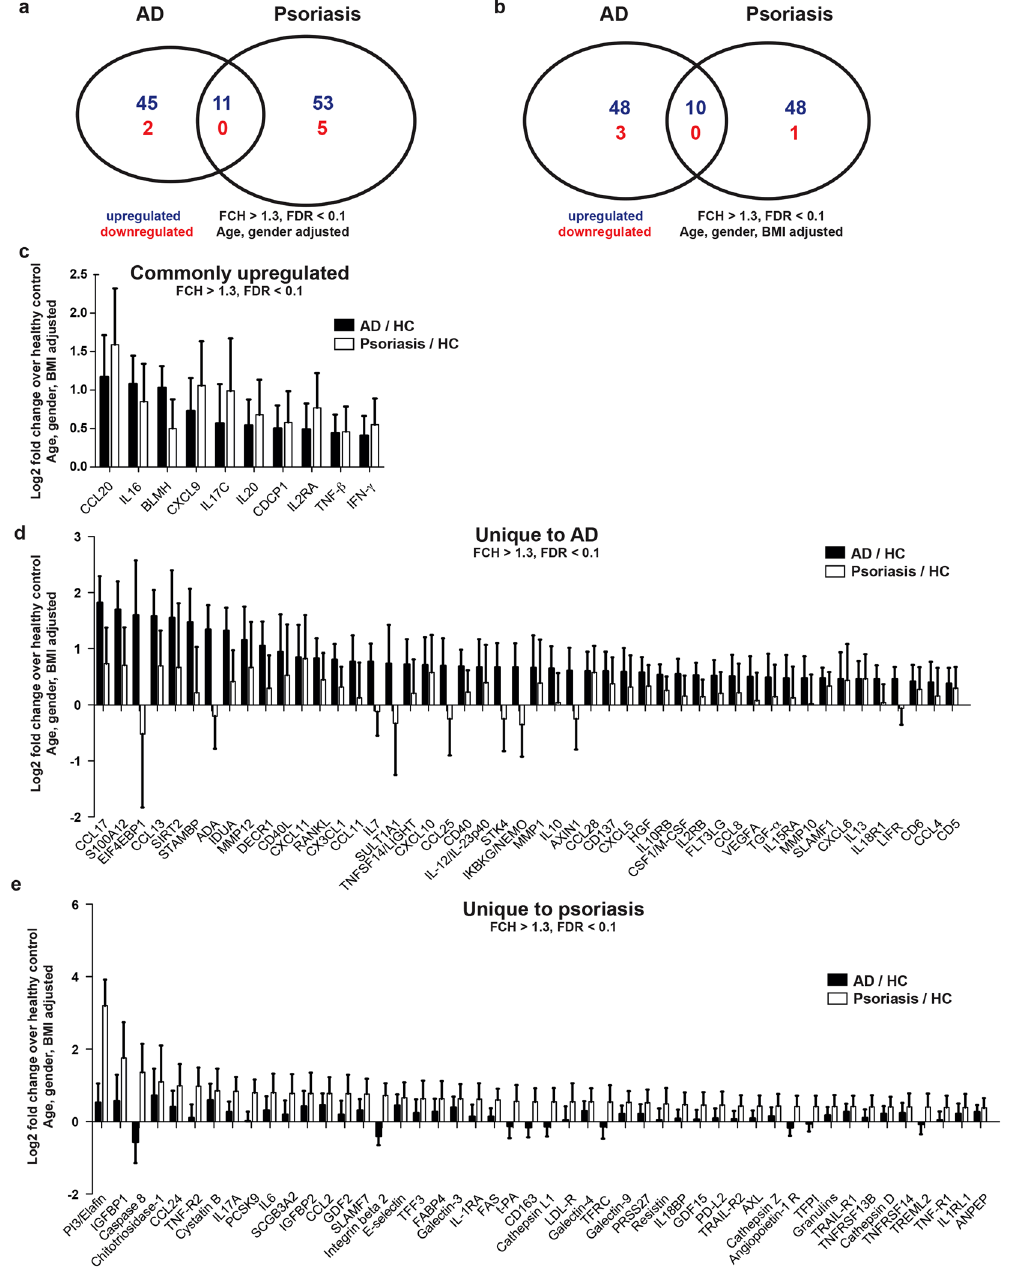
Figure 1. Regulation of inflammatory and cardiovascular risk proteins in AD and psoriasis vs. healthy controls. Venn diagrams of regulated serum proteins compared to healthy controls, adjusted for age/gender (a) and age/ gender/BMI (b) . Markers that were significantly upregulated (FCH > 1.3, FDR < 0.1) in both AD and psoriasis (c) , only in AD (d) or only in psoriasis (e) are depicted as log2 fold change over healthy control serum with their 95% confidence